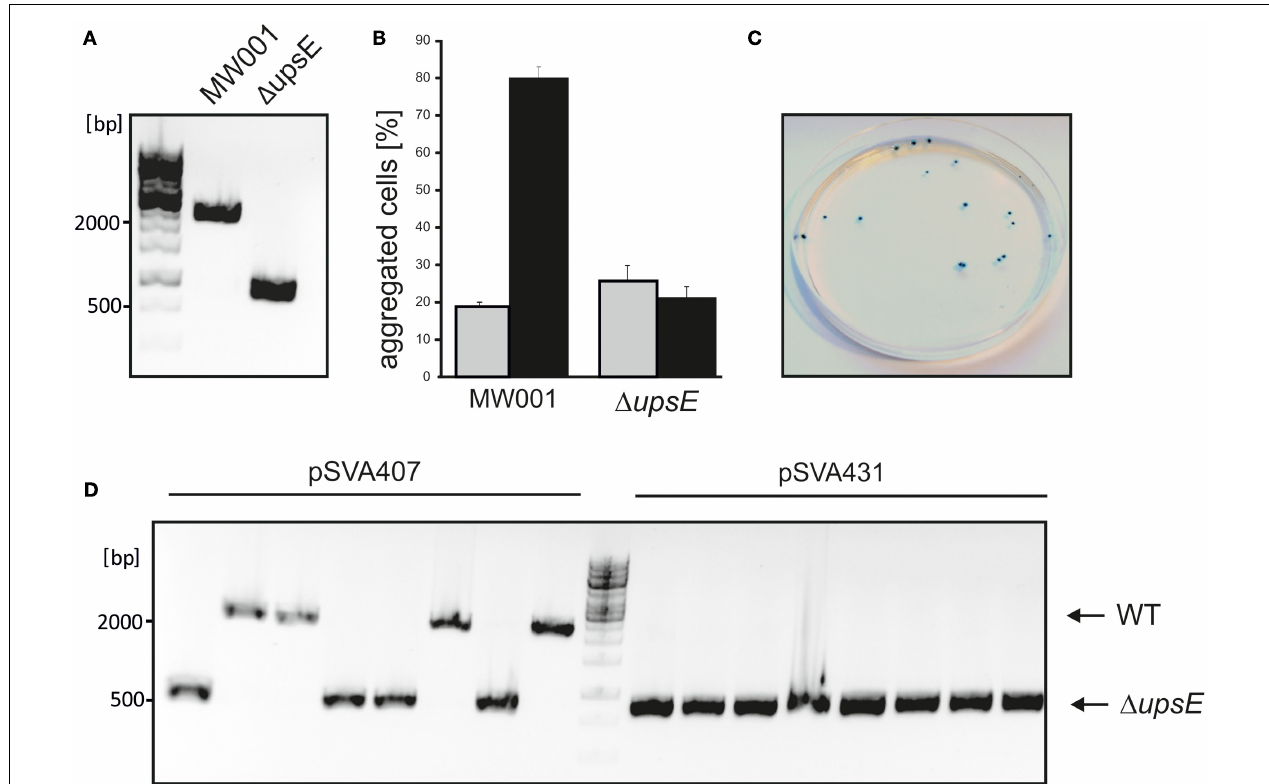
pSVA406, pSVA407, or pSVA431. A typical result of an UV induced aggregation assay is shown. Aggregation of wild type and deletion mutant were scored before (gray bar) or after UV treatment (black bar). (C) First selection plate colonies from a pSVA407 transformation was sprayed with X-gal. (D) A typical result of a mutant PCR screen with primers 2073/2015 using either plasmid pSVA406 or pSVA431 to obtain the deletion